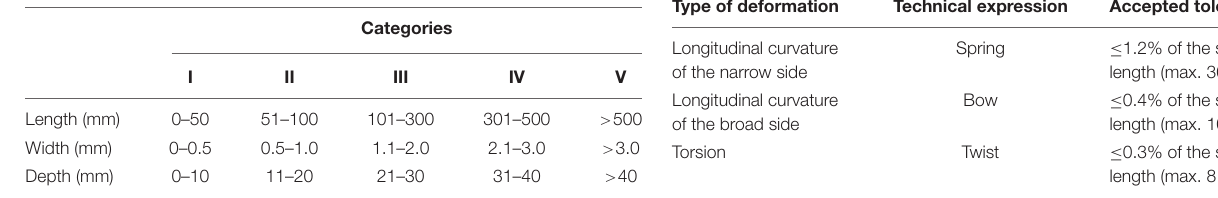
was defined, dividing check length, width and depth into five categories ( Table 1 ).